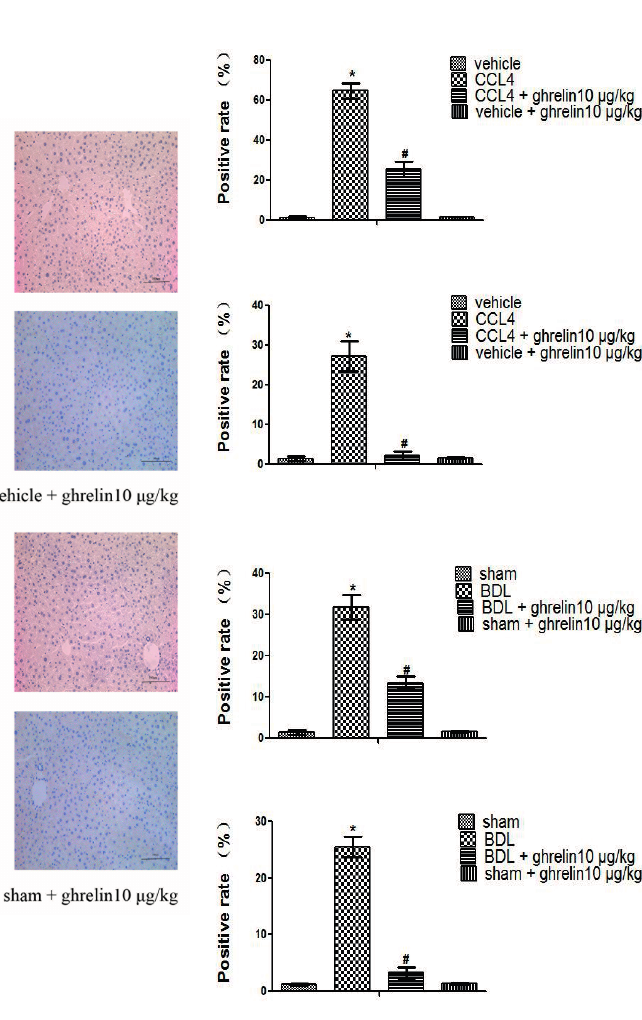
Figure 5. Ghrelin regulates the TGF- β 1/Smad3 signaling pathway. ( A ) Western blot analysis of TGF- β 1, p-Smad3, and Smad3 in the CCl 4 and BDL fibrotic mice models; ( B ) Real-time PCR analysis of TGF- β 1 is shown and ( C ) Immunohistochemical staining (200×) of TGF- β 1and p-Smad3 in both CCl 4 and BDL-induced fibrotic liver tissues. The positive rate was analyzed with Image-Pro Plus 6.0. ( n = 7, * p < 0.05 for the CCl 4 or BDL group vs. the vehicle or sham group, # p < 0.05 for the CCl 4 or BDL + ghrelin group vs. the CCl 4 or BDL group). The scale bar of each figure is 200 μ m, and the magnification is